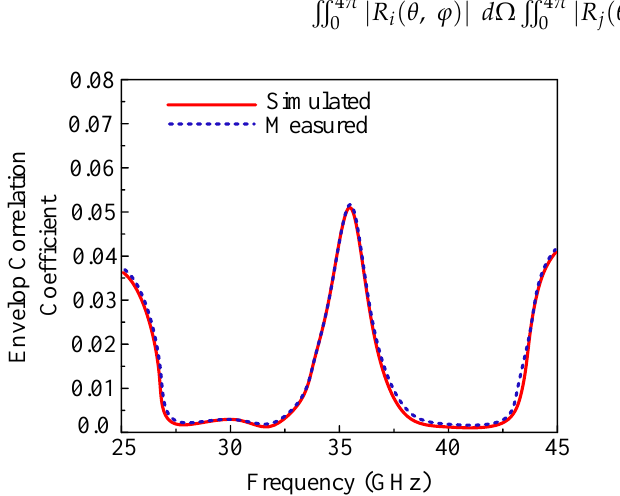
Figure 13. Envelop Correlation Coefficient (ECC) of the proposed parasitic element-loaded dual-band MIMO antenna.